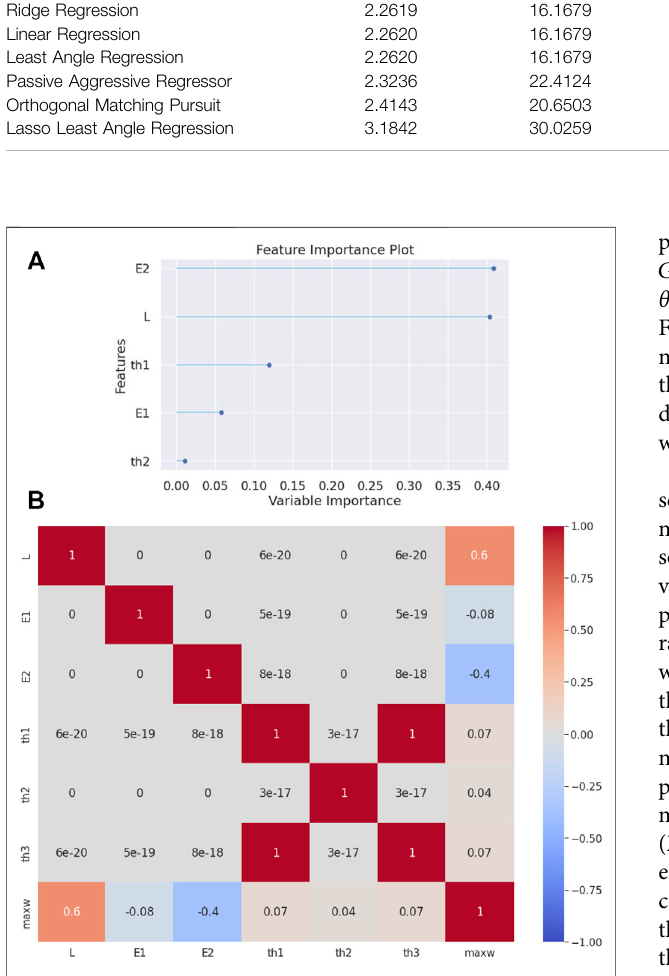
FIGURE 4 | (A) Feature importance plot and (B) correlation matrix heatmap for the clamped-roller beam.